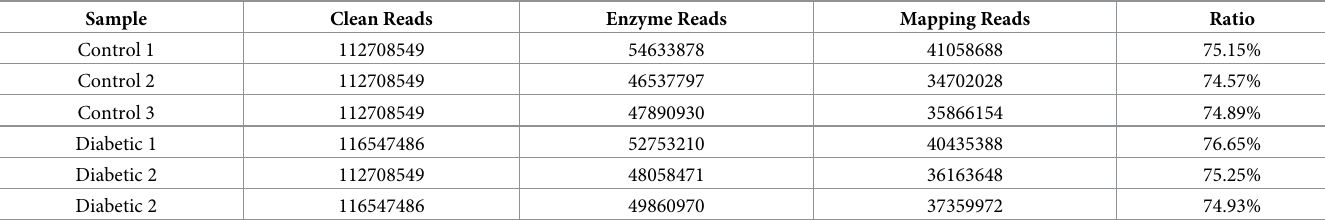
Table 1. Overview of sequencing and